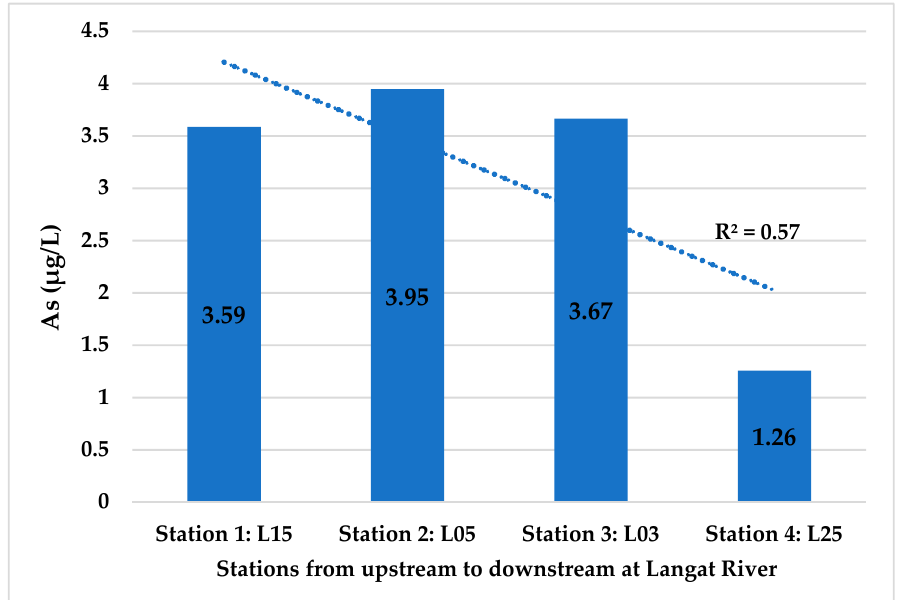
Figure 6. Prediction of As ( μ g/L) concentration at water stations for December 2024.